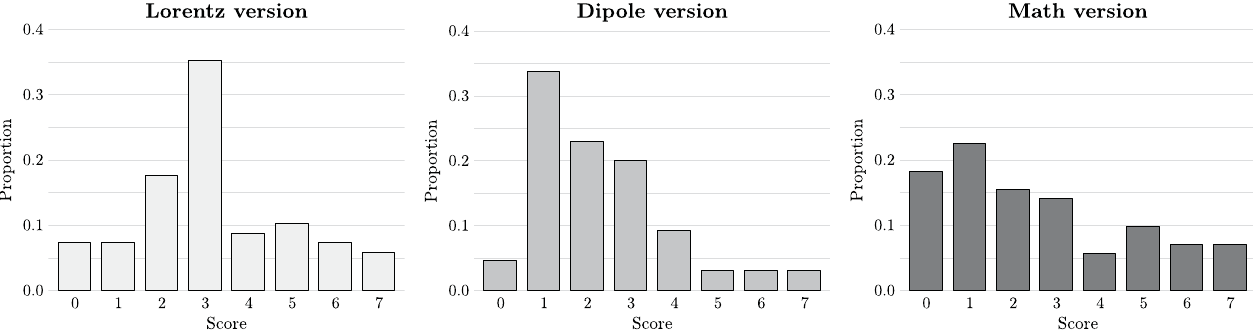
FIG. 2. Students ’ scores on the Lorentz (left), dipole (middle), and math (right) version. A correct answer on a question counts as one, a wrong answer as